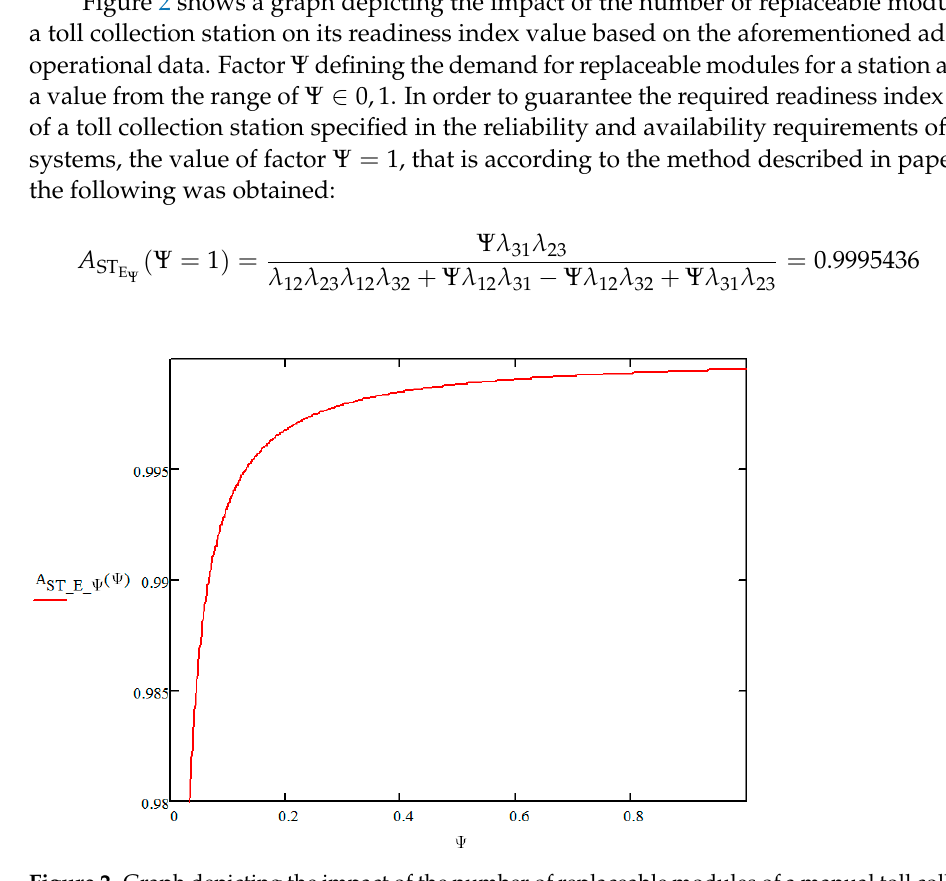
Table 2. List of the number of replaceable modules at a toll collection station for the determination of its readiness index appropriate value. Source: own study based on [14].